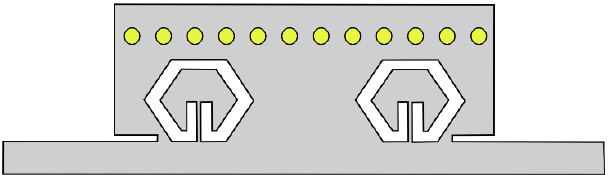
FIGURE 9. Top view of the proposed HMSIW and C-HMC band-pass